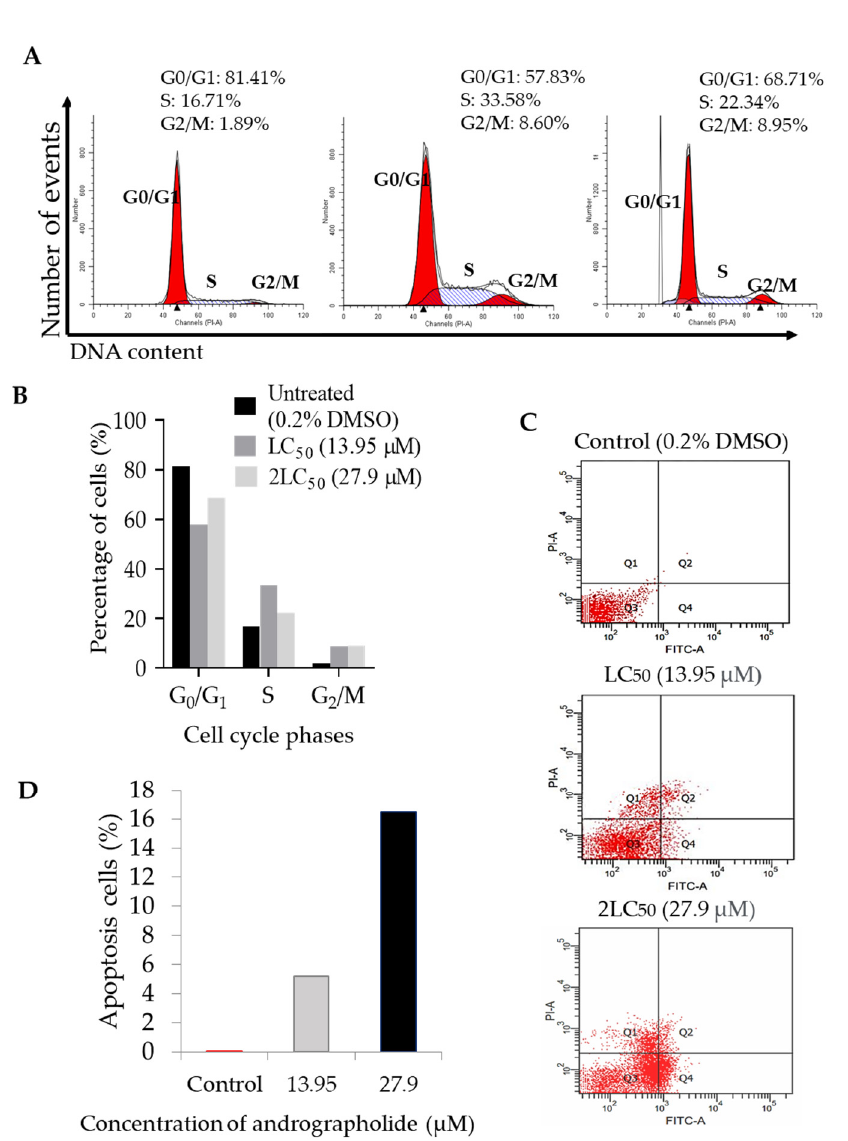
Figure 4. The cell cycle distribution of DBTRG-05MG cell lines. ( A ) The cell was distributed in the population of G0/G1, S, and G2/M of cell cycle phases after 72 h exposed to different concentrations of andrographolide (13.95 µM and 27.9 µM) compared with untreated cells (0.2% DMSO). ( B ) The percentage of cells (%) for each cell cycle phase is shown in the bar graph. ( C ) Apoptosis analysis of DBTRG-05MG cell lines after exposure with LC 50 (13.95 µM), 2LC 50 (27.9 µM) of andrographolide, and control (0.2% of DMSO) were observed using annexin V-FITC and PI staining. ( D ) The percentage of apoptosis cells increased after the concentration of andrographolide increased compared to control.